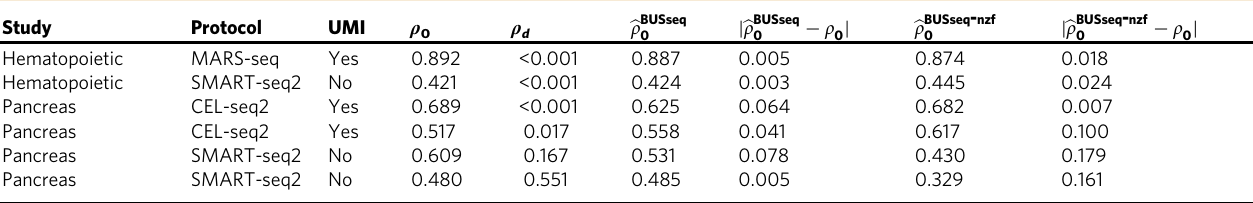
Table 1 Zero-count rates and dropout rates of the hematopoietic and pancreas